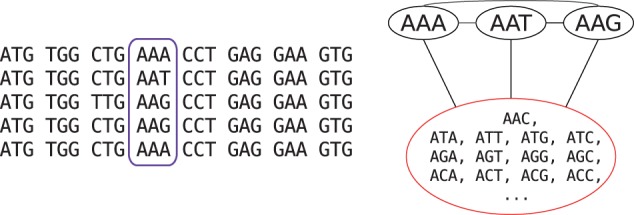
Example of state aggregation for one position (highlighted in purple) in a codon alignment